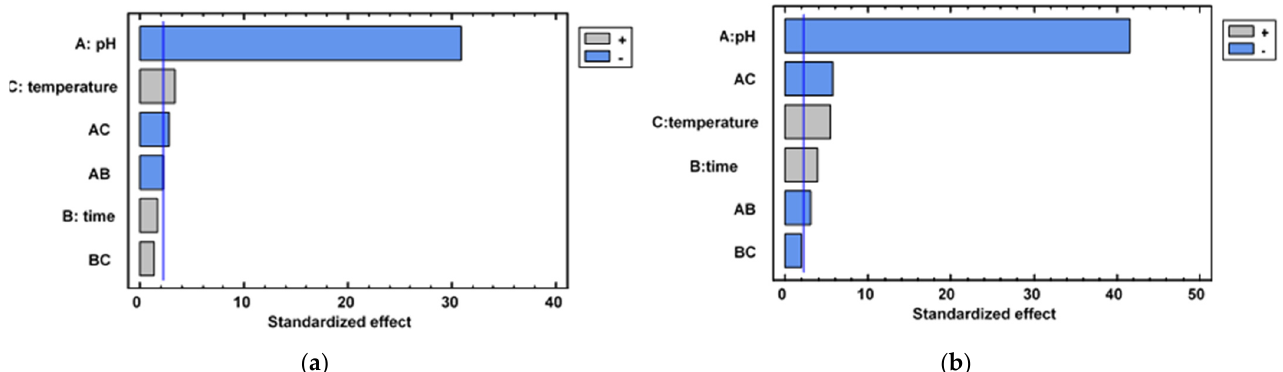
Figure A1. Pareto charts of ( a ) Tahiti lime ( b ) King mandarin.